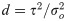
Evidence-based shrinkage.Shrinkage factor s as function of the test statistic to (bottom axis) and the two-sided p-value po (top axis) of the original study and the relative between-study heterogeneity d=τ2/σo2.